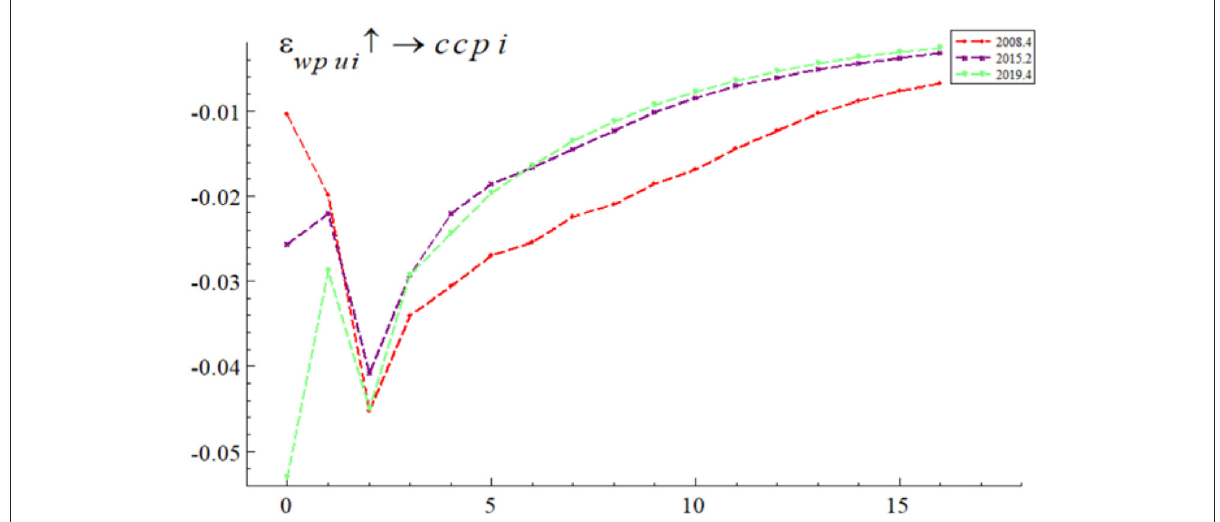
FIGURE4 The effect of WPU on China’s commodity prices at different points in time. The red line represents the fourth quarter of 2008, the purple line the second quarter of 2015, and the green line the fourth quarter of